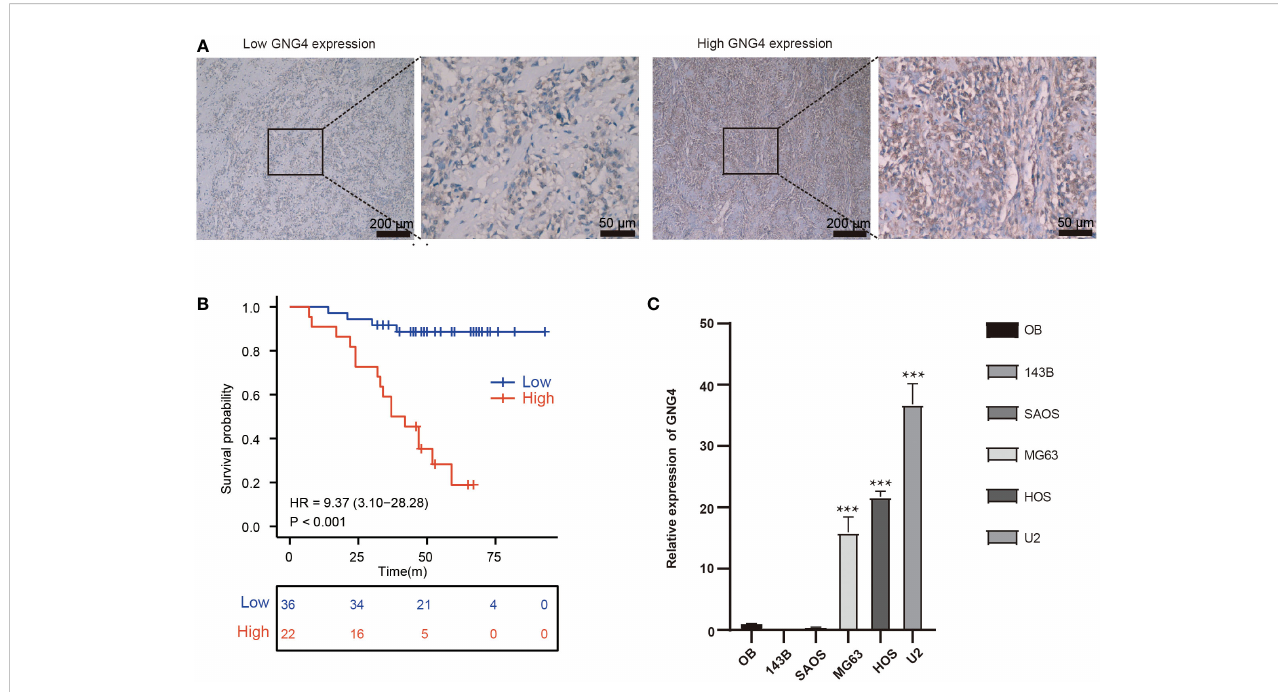
FIGURE 6 Veri fi cation of the expression and prognostic value of GNG4. (A) Immunocytochemical staining of GNG4 in OS tissues. (B) In the validation cohort, the effect of high GNG4 expression on overall survival prognosis was statistically signi fi cant. (C) GNG4 expression in hFOB cells and fi ve OS cell lines. p<0.001 was considered as signi fi cant difference